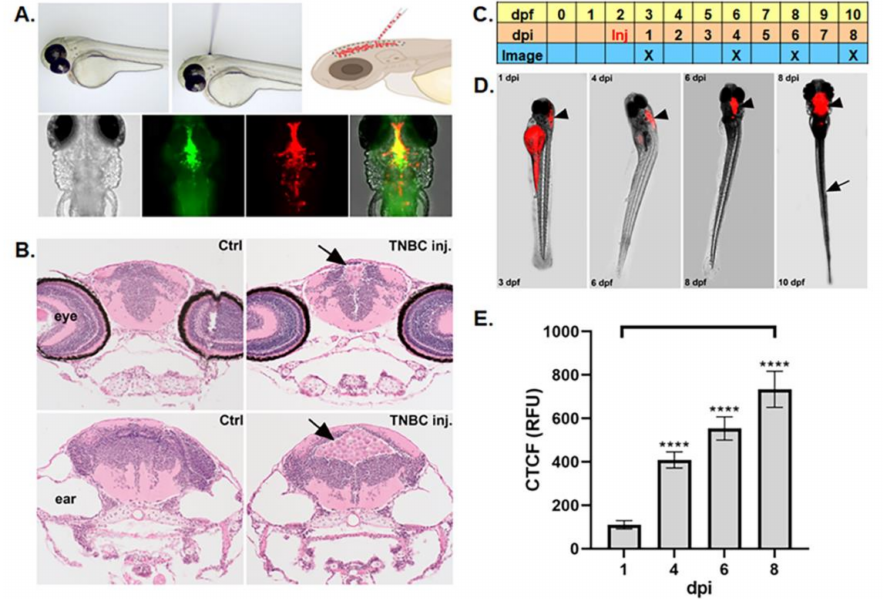
Figure 1. Microinjection of fluorescent labeled TNBC cells into the zebrafish hindbrain ventricle facilitated measurement of tumor area and metastasis. ( A ). Top row left: lateral view of zebrafish embryo prior to injection; top row center: lateral view of embryo injection; top row right: diagram of zebrafish microinjection with cancer cells indicated in red; bottom row far left: dorsal bright- field view of zebrafish cranial region; bottom row inner left: dorsal view after microinjection with green dextran fluorescein dye (to label ventricle); bottom row inner right: dorsal view after mi- croinjection with red DiI-labeled TNBC cells; bottom row far right: dorsal view of red–green color combination. ( B ). Hematoxylin and eosin staining cross-sectional study showing rostral view (top row) and caudal view (bottom row) comparing control uninjected samples (left panels) with ventricle MDA-MB-231 TNBC-injected samples (right panels; injected TNBC cells indicated in different brain ventricles with arrows) ( C ). Schematic timeline for experiments showing days postfertilization (dpf), days postinjection (dpi), injection time (Inj), and imaging time points. ( D ). Fluorescent tracking of MDA-MB-231-Luc/RFP labeled TNBC cells over 1, 4, 6, and 8 dpi (arrow heads: labeled cancer cells localized in hindbrain; arrow: labeled cancer cells in caudal section). ( E ). Measurement of corrected total cell fluorescence at 1, 4, 6, and 8 dpi. Key: corrected total cell fluorescence (CTCF); p < 0.05, “****” = 0.0001; Error bars = SEM; N for 1, 4, and 6 dpi samples = 44; N for 8 dpi samples =